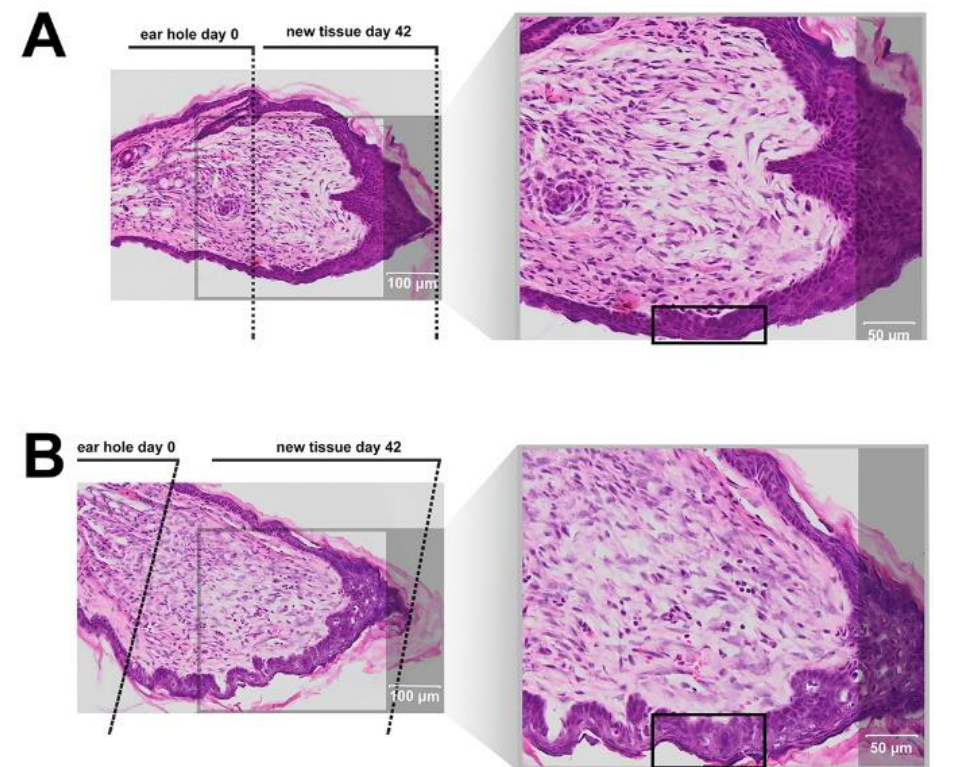
Figure 8. Histological examination of BALB / c mice ear pinna tissue harvested after 42 days of treatment with vehicle only (saline) ( A ) or treatment with IM ( B ). Frames mark enhanced epidermis regeneration. The zone of restoration was calculated by subtracting the radius of ear hole at day 42 from the radius of the initial ear hole.